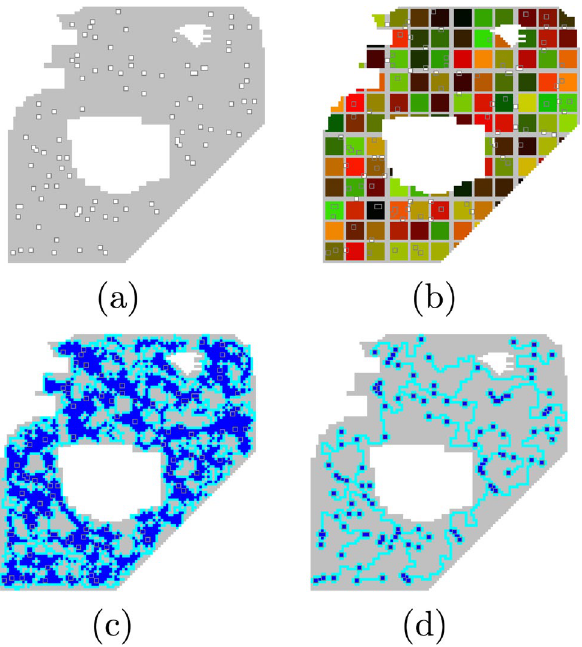
Figure 6. (a) Sample boundary map. Grey area is search area and small white squares are points. (b) Initial deployment of Physarum . (c) Solution at the end of the foraging stage. (d) The final